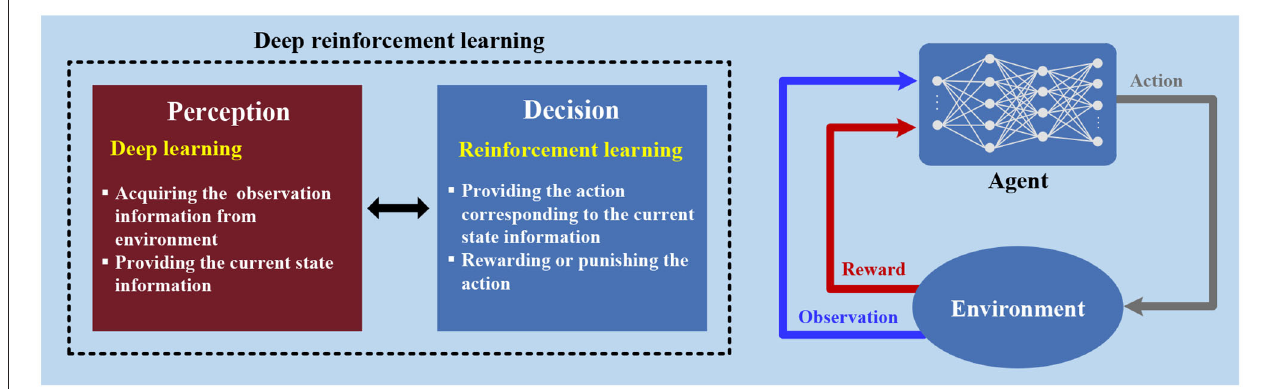
FIGURE 6 | Schematic of deep reinforcement learning combing advantages of perception from deep learning and decision-making from reinforcement learning, to provide a policy for complex controlling problems. Through observation, an agent can acquire the current information from the environment and adjust the action to maximize cumulative rewards for a specific